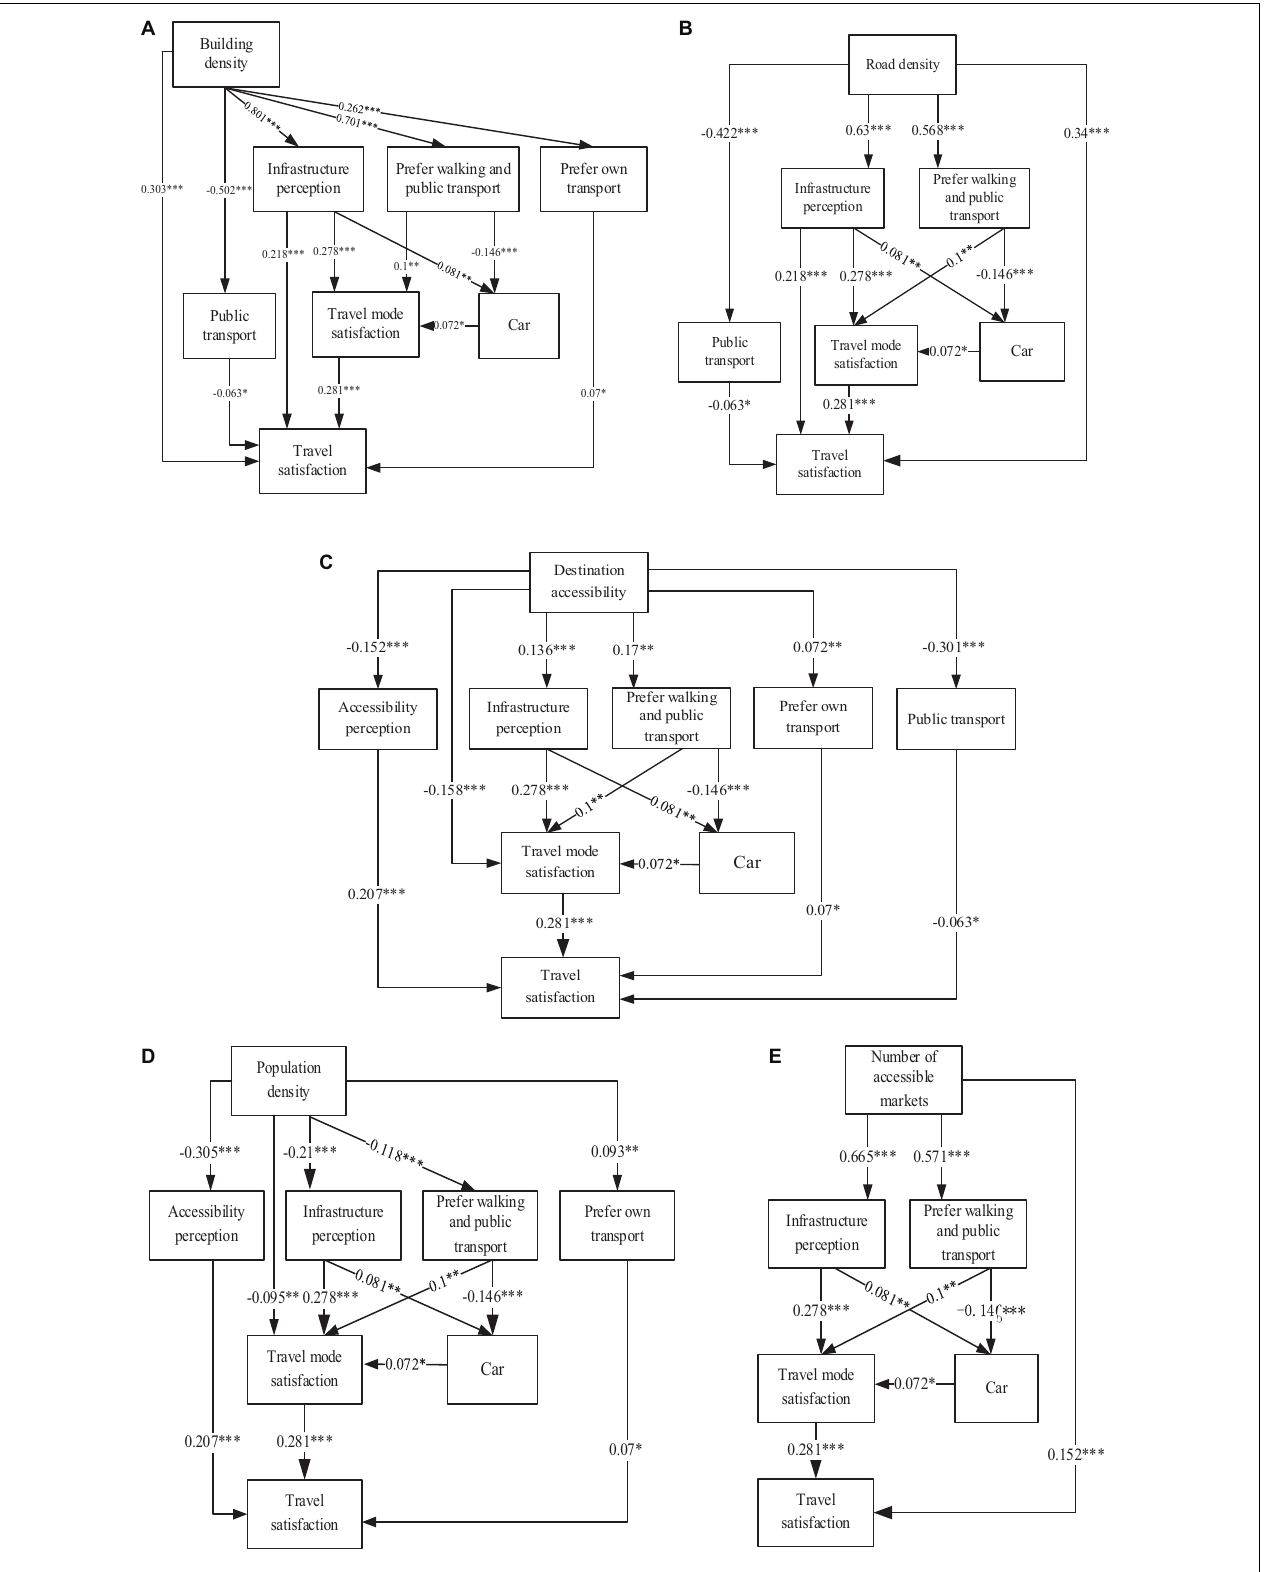
FIGURE 8 | (A) Building density. (B) Road density. (C) Destination accessibility. (D) Population density. (E) Number of accessible markets. ***Represents p value < 0.01, **Represents p value < 0.05, and *Represents p value < 0.1.